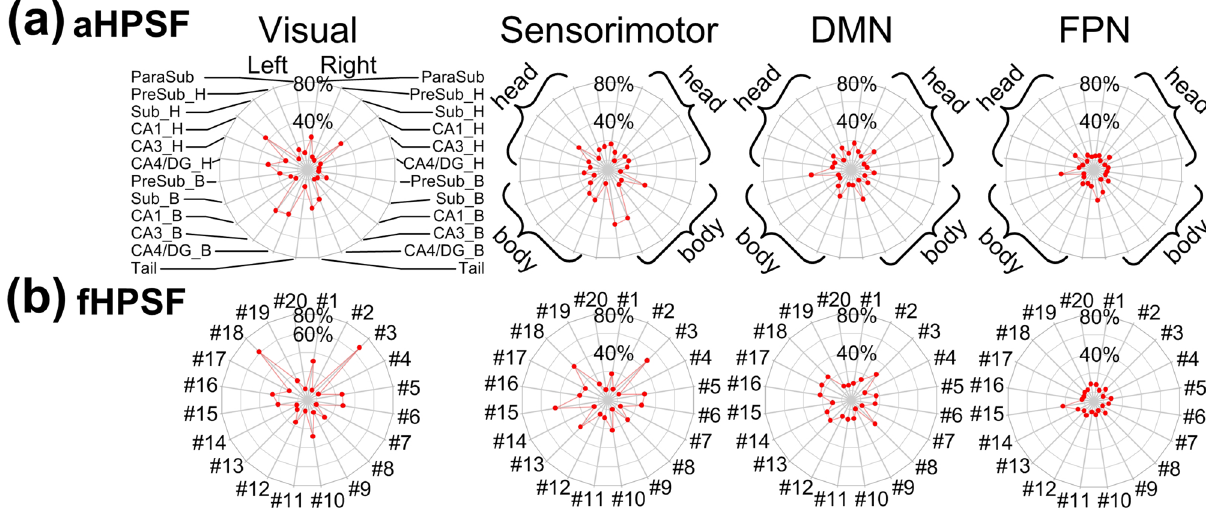
Figure 5. The percentages of iFC coverage of each RSN associated with ( a ) aHPSFs and ( b ) fHPSFs. The radar charts from left to right panels correspond to visual network, sensorimotor network, DMN and FPN. The names of aHPSF are only illustrated in the left most panel in ( a ). The head and body portions of aHPSF are highlighted by curly brackets in the other panels. For the radar charts of fHPSF in ( b ), the indices of fHPSFs were arranged from anterior to posterior. The index #1 was assigned to the most anterior fHPSF and #20 to the most posterior fHPSF. The innermost and outermost isoparametric curves in the radar plots represent 0% and 80% respectively. The increment between adjacent isoparametric curves is 20%. L left; R right; H head; B body; Sub subiculum; CA cornu ammonis; DG dentate gyrus; FPN frontoparietal network; DMN default-mode network.